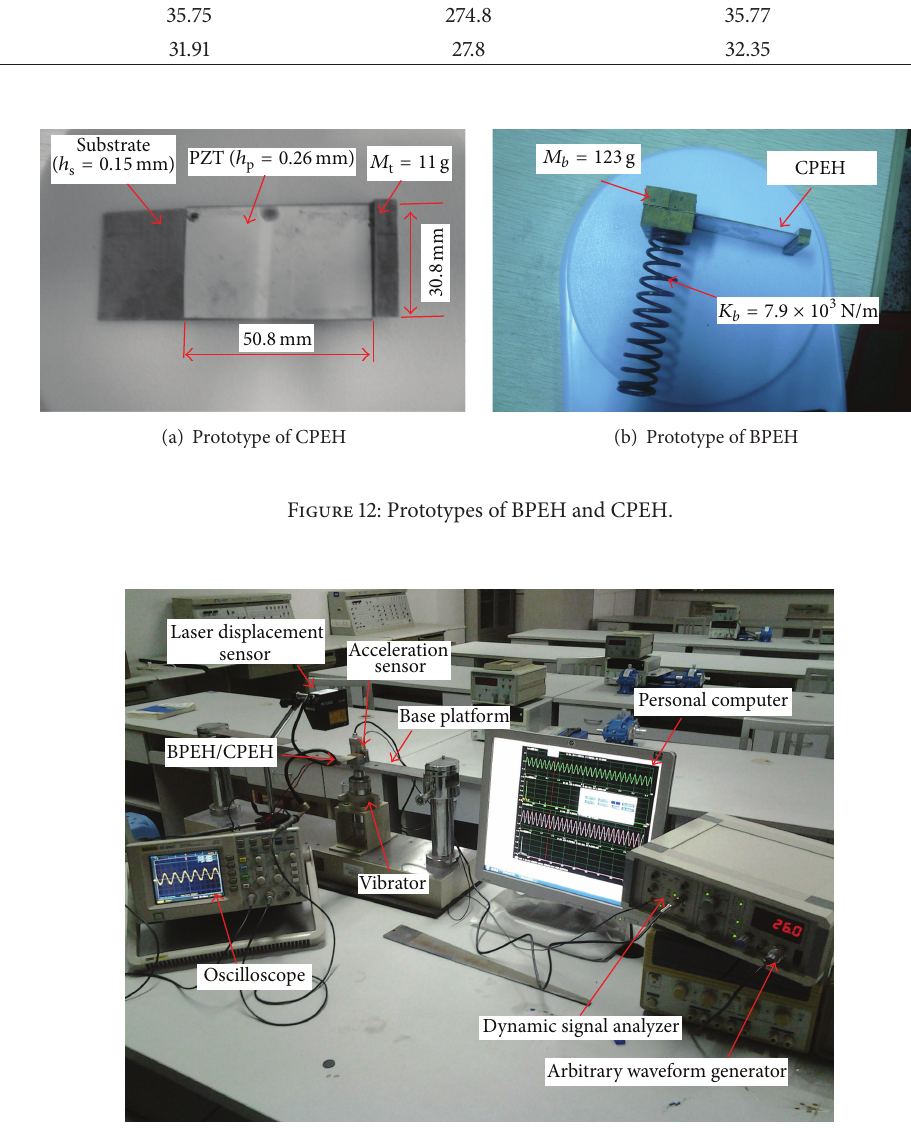
Figure 13: Experiment setup for the BPEH and